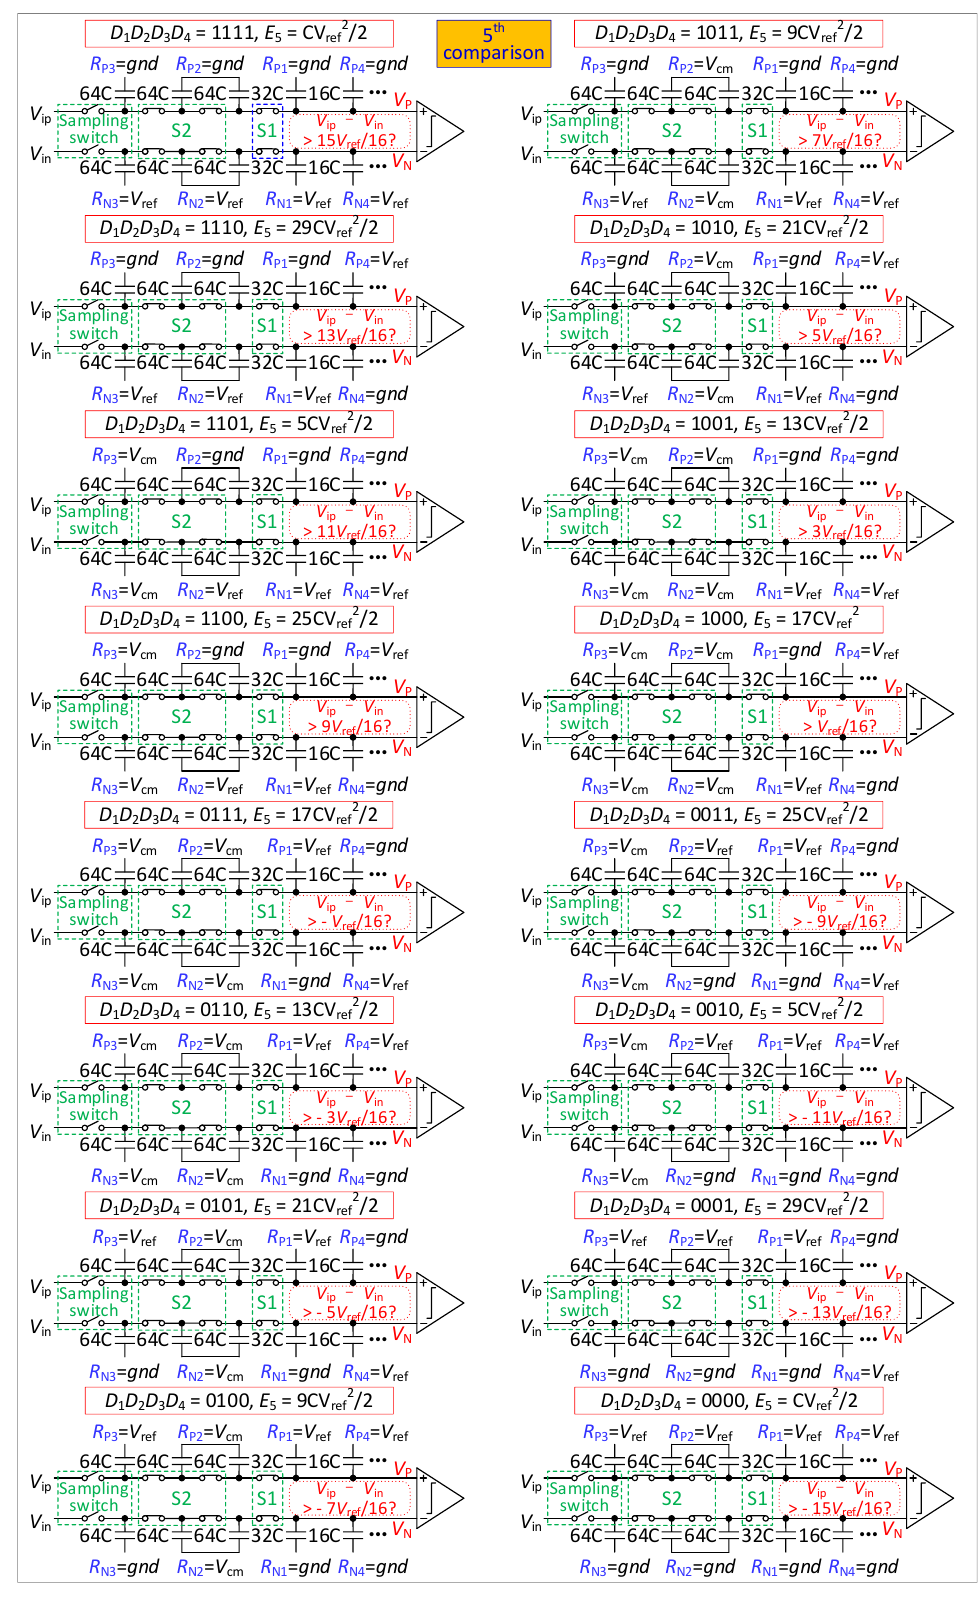
Figure 5. The 5th comparison diagram of the proposed 10-bit mode switching scheme.